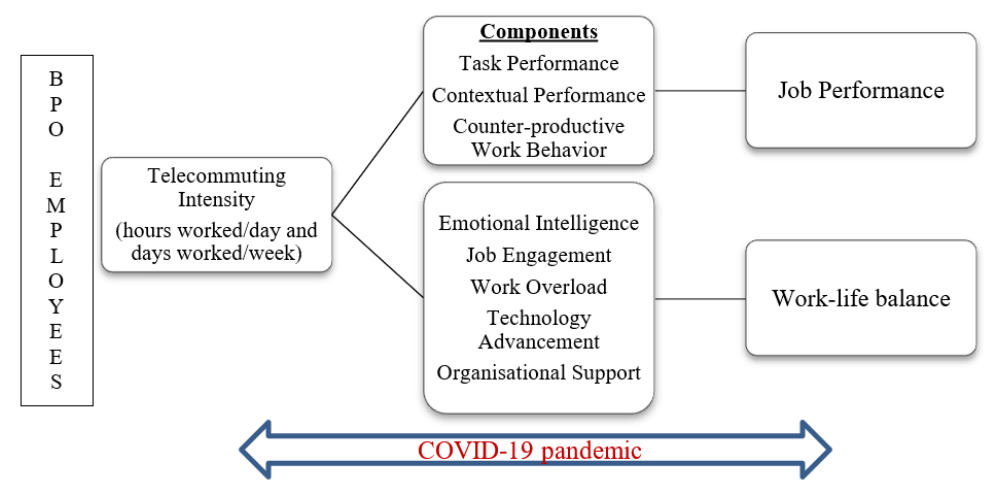
Fig. 3. Conceptual framework on the relationship between telecommuting intensity and employees’ job performance and work-life balance during the COVID-19